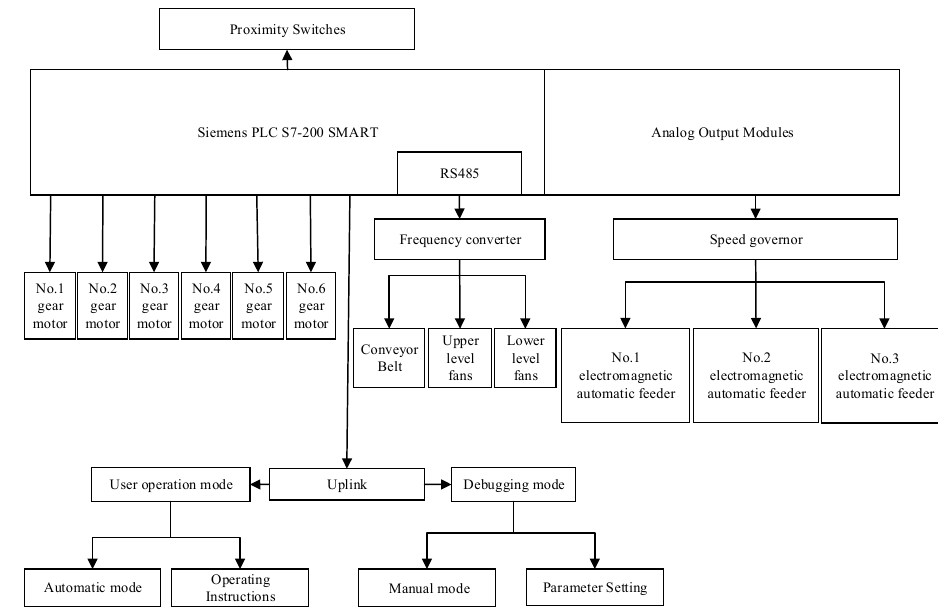
Figure 5. Block diagram design of double-layer tea winnowing machine control system.